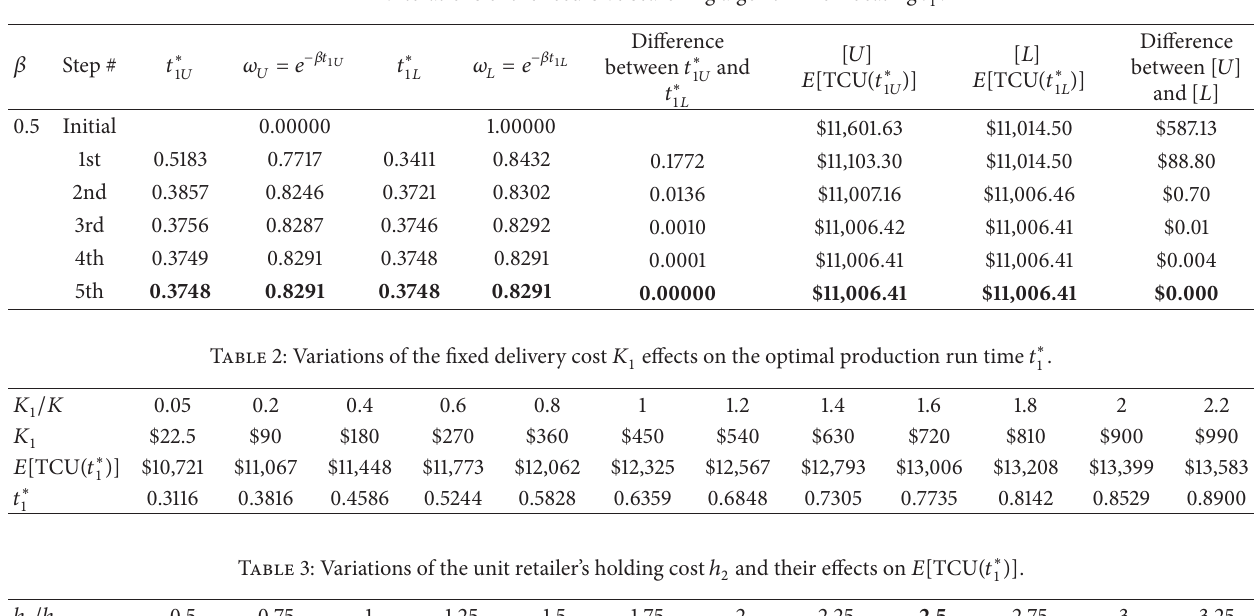
Table 1: Iterations of the recursive searching algorithm for locating 𝑡 ∗ 1 .